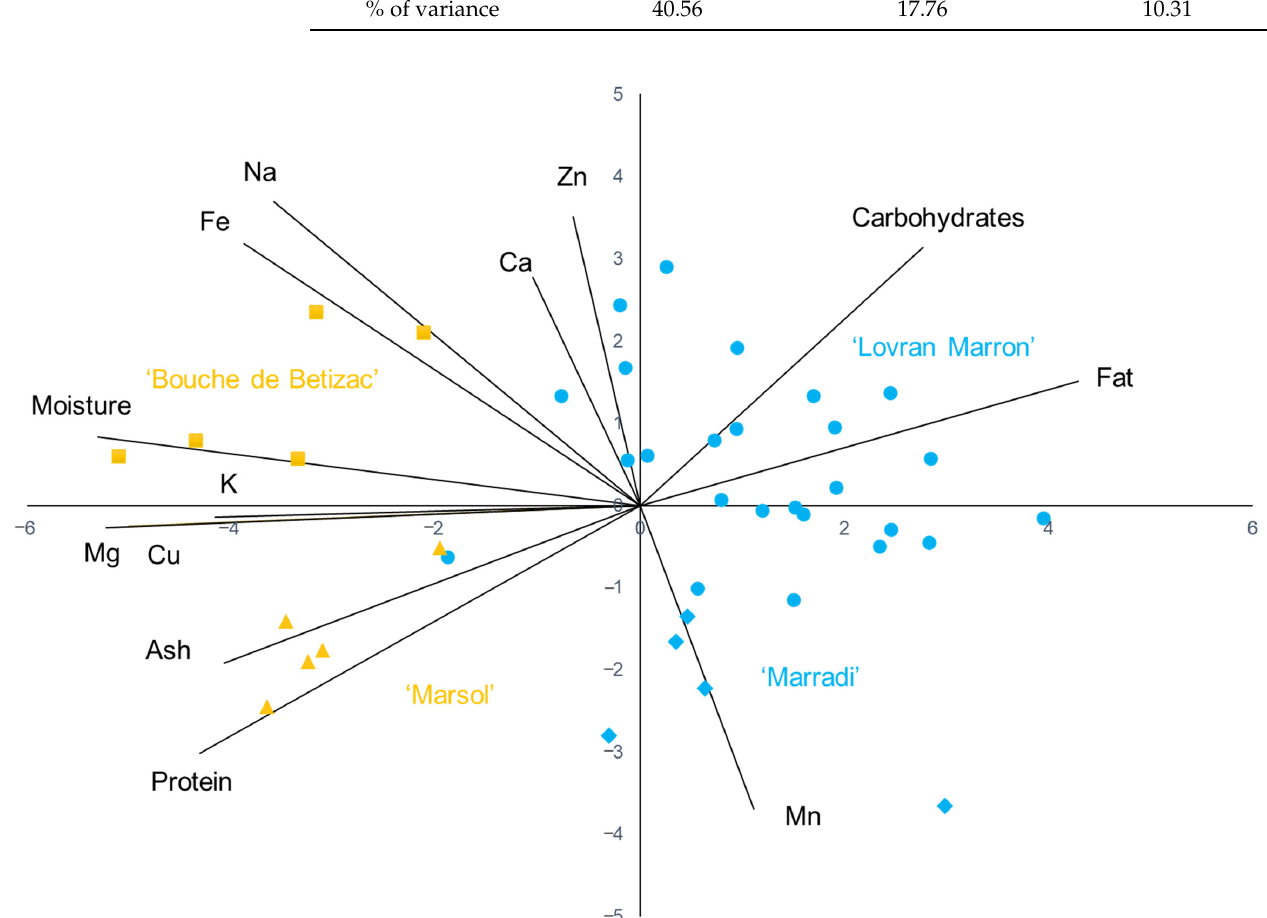
Figure 3. Biplot of the principal component analysis based on 13 chemical traits in studied traditional and hybrid chestnut varieties.